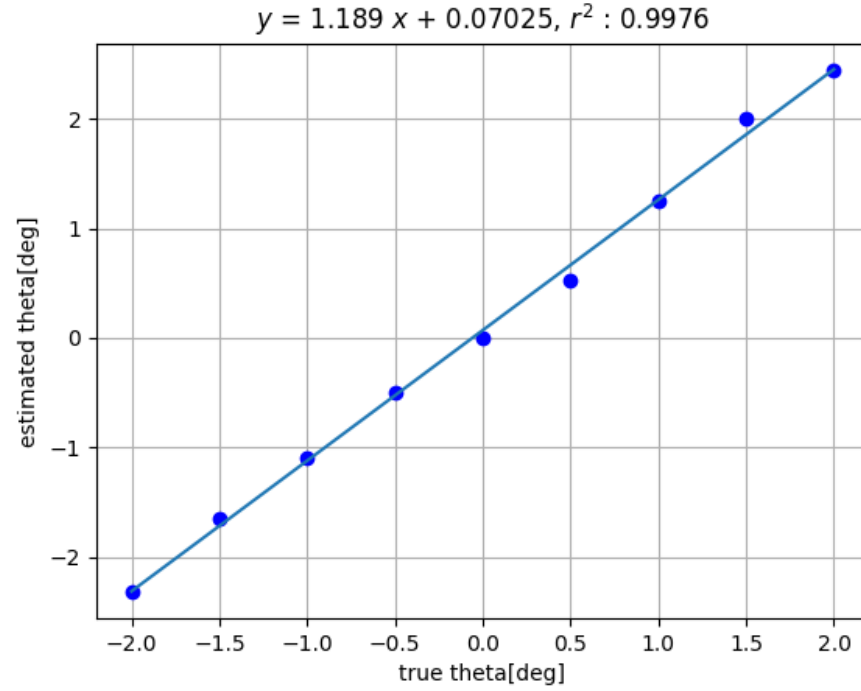
Figure 9. Result of tilt angle estimation by Method 1.